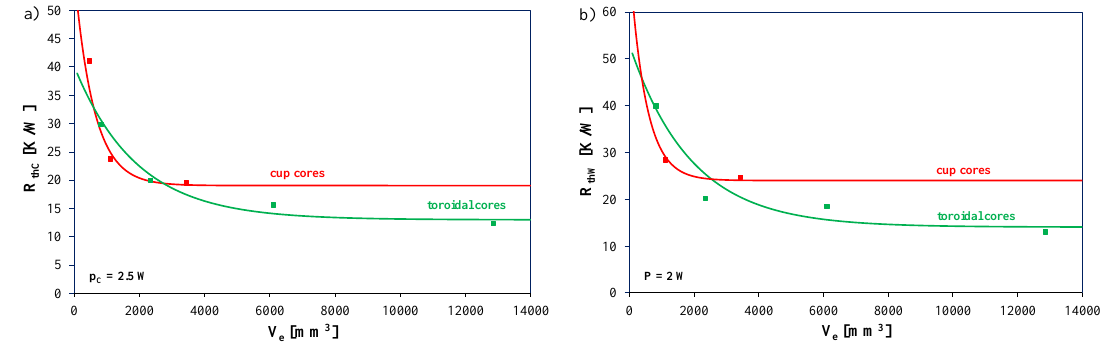
Figure 17. Measured and calculated dependences of thermal resistance of the core R thC ( a ) and thermal resistance of the winding R thW ( b ) on the effective volume of the core for inductors with cup cores and toroidal cores.